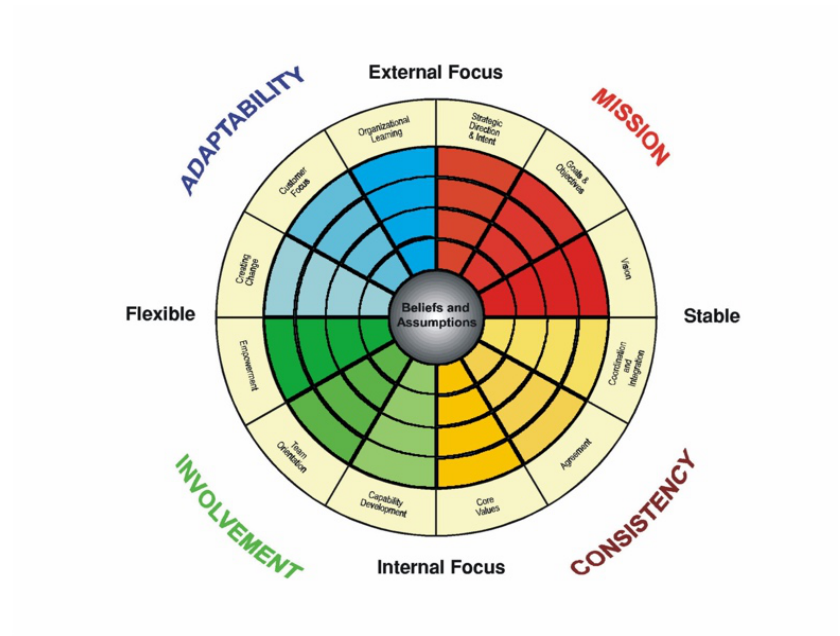
Figure 1 : Denison’s Organizational Culture